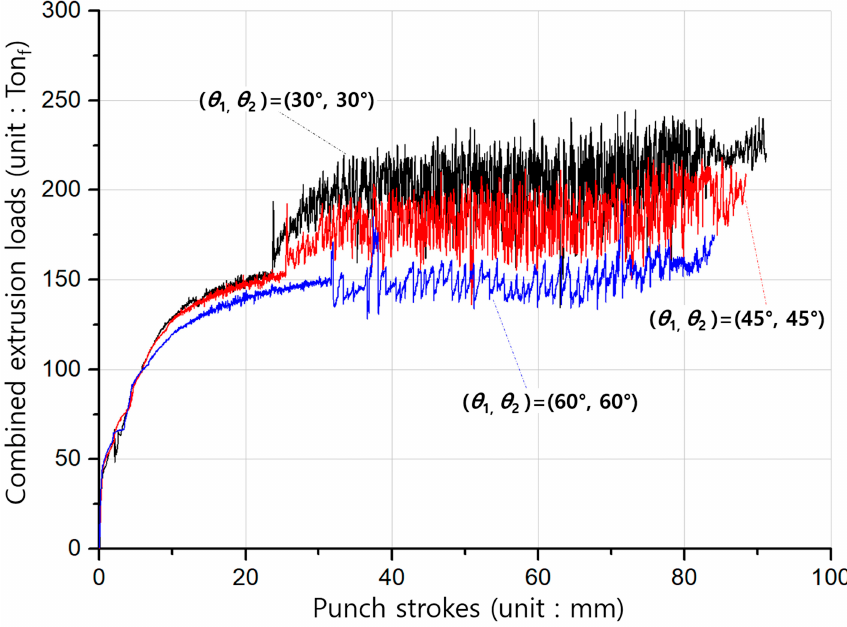
Figure 10. Cold forging load histories for the combined extrusion of the drive shaft.